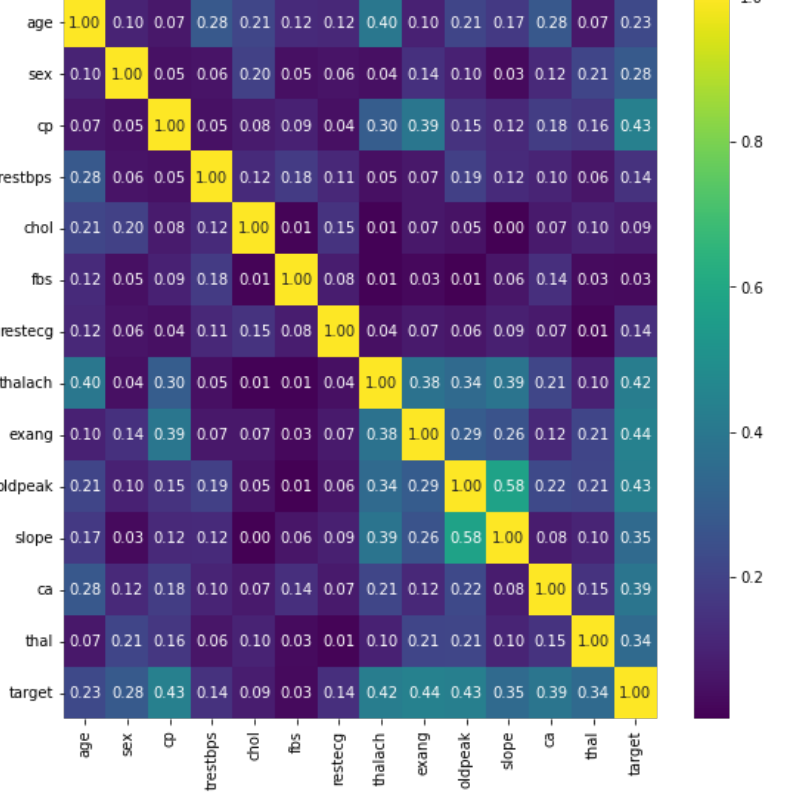
Figure 4. Dataset features heatmap.